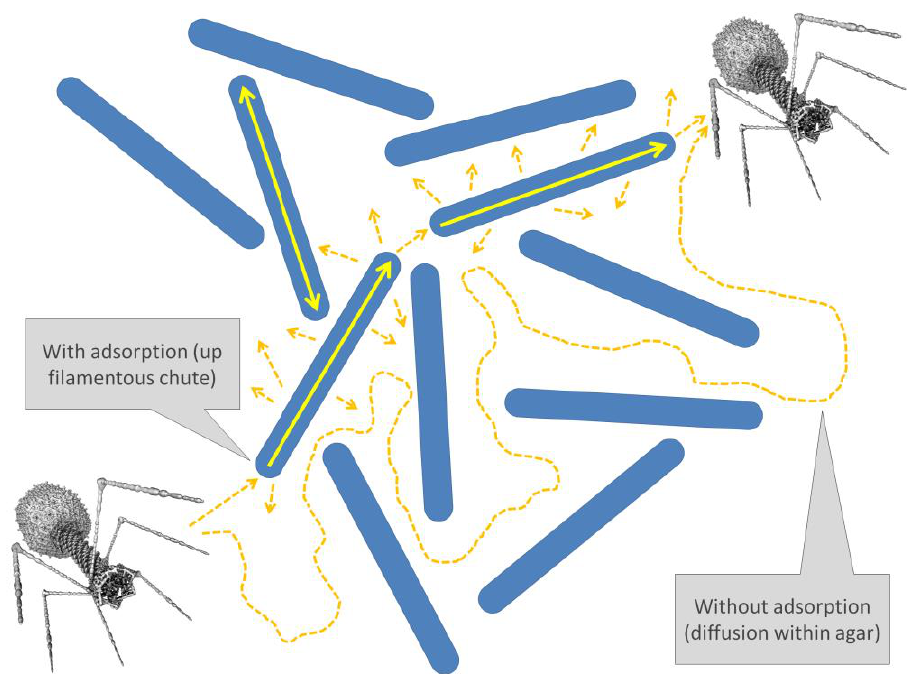
Figure 5. Proposed phage use of filamentous bacteria as a means of speeding up plaque growth. If bacteria are long enough, latent periods short enough, and diffusion (dashed orange arrows) through agar slow enough, then infection of appropriately oriented bacteria could serve as ‘ladders’ (solid yellow arrows) for movement of phages faster or deeper into a bacterial lawn than virions may be able to progress extracellularly by diffusion alone.